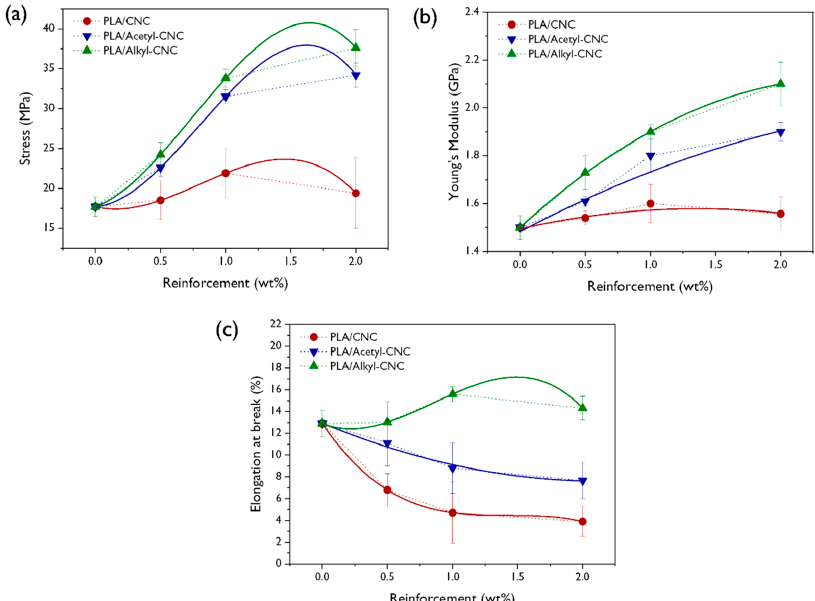
Figure 6. ( a ) Stress-strain curves, ( b ) young’s modulus, and ( c ) elongations at break of